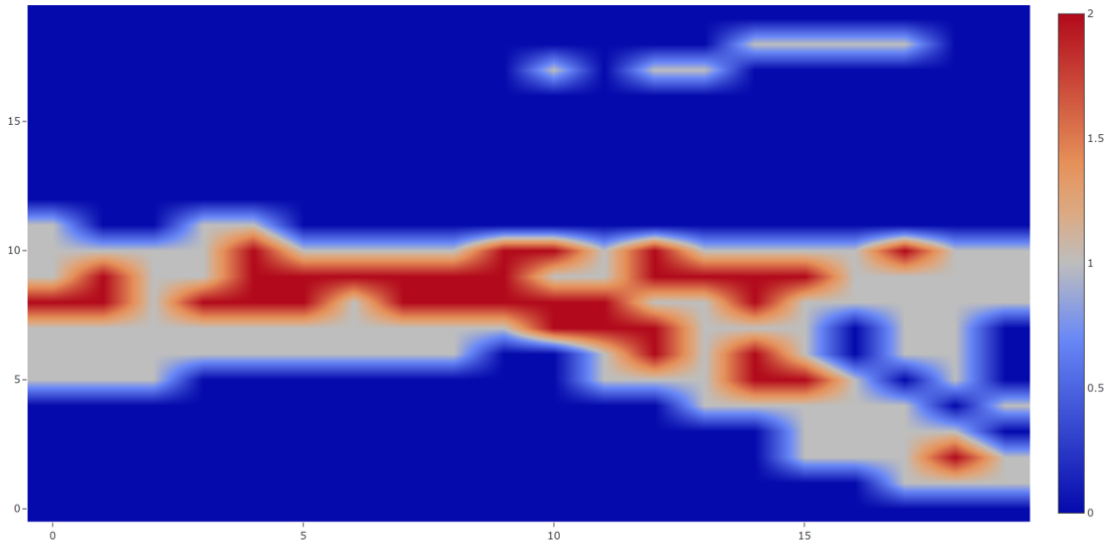
Figure 16. Heat map of the maximum number of individual detected in the field of view of the